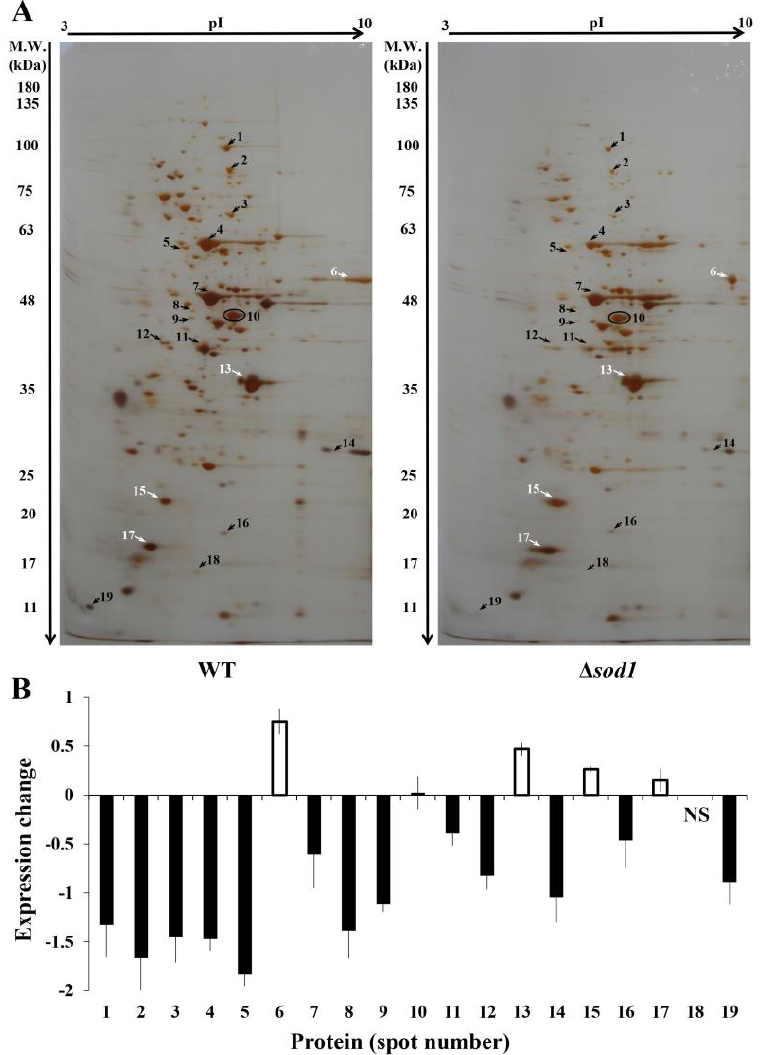
Figure 1. Comparison of the WT strain and ∆ sod1 mutant proteomes ( A ) Representative two-dimensional gel electrophoresis of protein extracts of the WT strain (lefthand side of the gel) and the ∆ sod1 mutant (righthand side of the gel). Differentially expressed proteins are indicated in the gels with respective numbers. Downregulated proteins are indicated by black arrows and upregulated ones by white arrows. Protein spot number 10 is a control (indicated by a circle). ( B ) Expression change (Log2 of fold) of proteins was calculated for the respective protein 2-DE spots of the ∆ sod1 mutant and the WT strain. Data are presented as a mean ± SD of three independent experiments. NS—no protein spot for the ∆ sod1